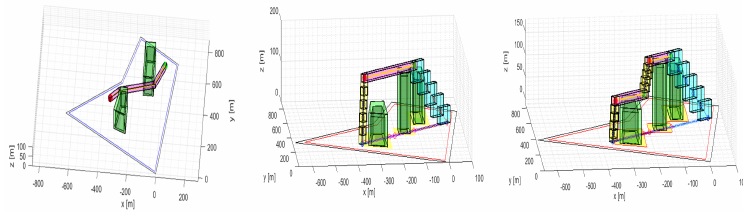
Figure 6. Three candidate flight planning solutions respecting keep-out airspace geofence and obstacle “no-fly” volumes. A turn solution uses a visibility graph to define a constant-altitude path around no-fly zones ( left ). A cruise altitude solution climbs to an altitude greater than the highest building enroute to the destination ( center ). The terrain follower defines an altitude profile maintaining minimum safe clearance or greater from no-fly zones ( right